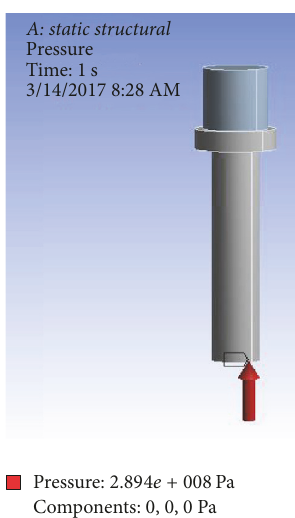
Figure 13: NATO proof barrel with copper crusher fixture.